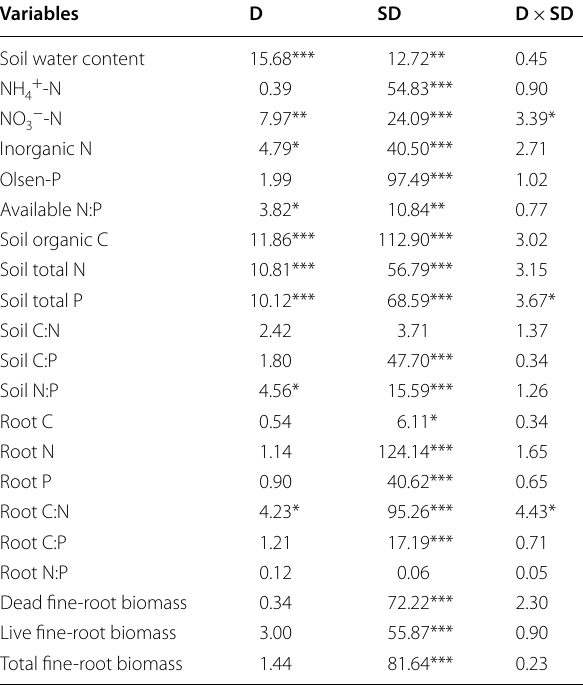
Table 1 Two‑way ANOVA test ( F values) for the effects of drought treatment (D), soil depth (SD), and their interaction (D SD) on soil water content and nutrient availability, ×